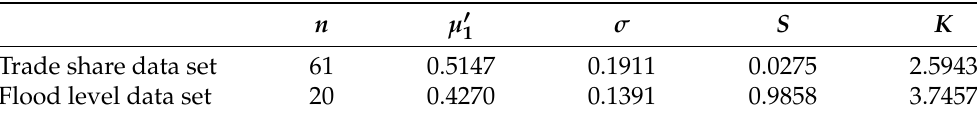
Table 13. Estimates moment measures for the two data sets.